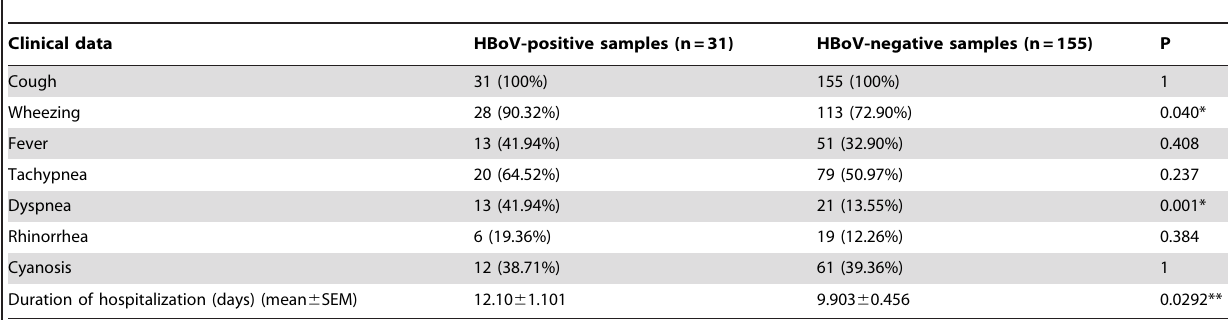
Table 2. Clinical features of HBoV-positive